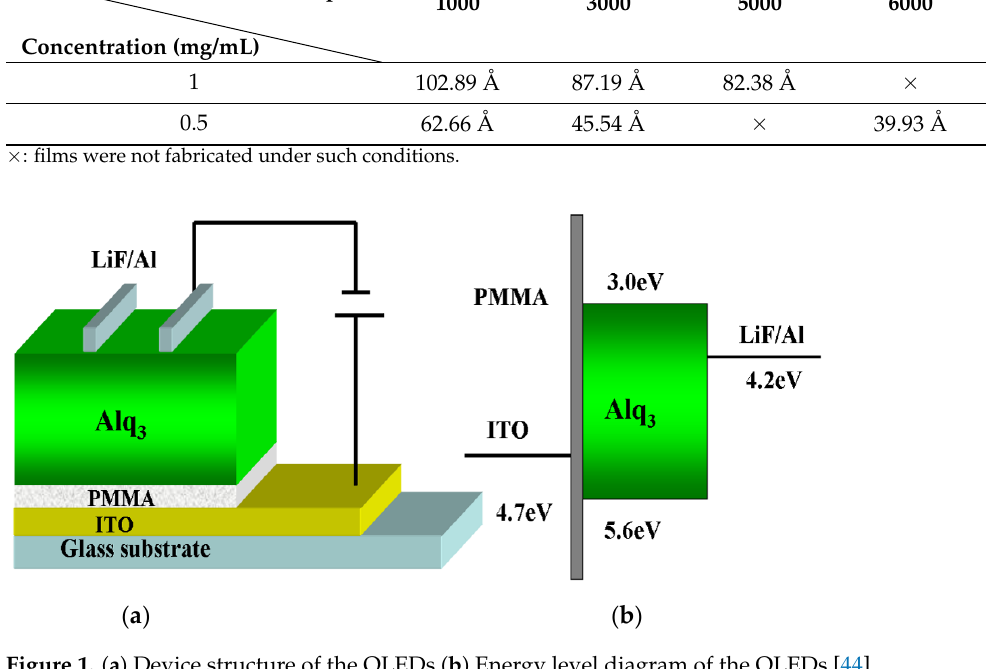
Table 1. The thickness of spin-coated PMMA film measured by an ellipsometer. Concentration